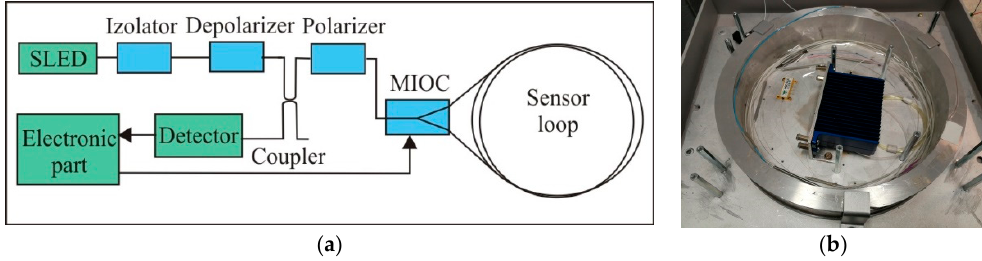
Figure 2. The optical part of the sensor according to a minimum gyro configuration: ( a ) block diagram, ( b ) technical realization for FOSREM-1. MIOC: multifunction integrated optic chip. SLED: superluminescent light emitting diode.